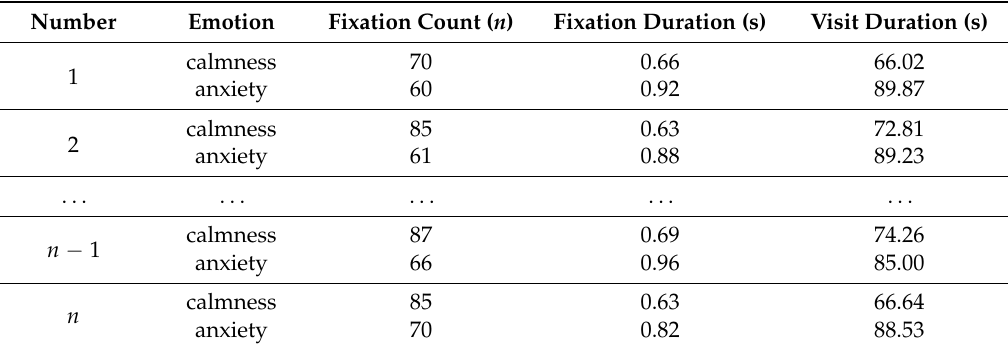
Table 3. Parts of data